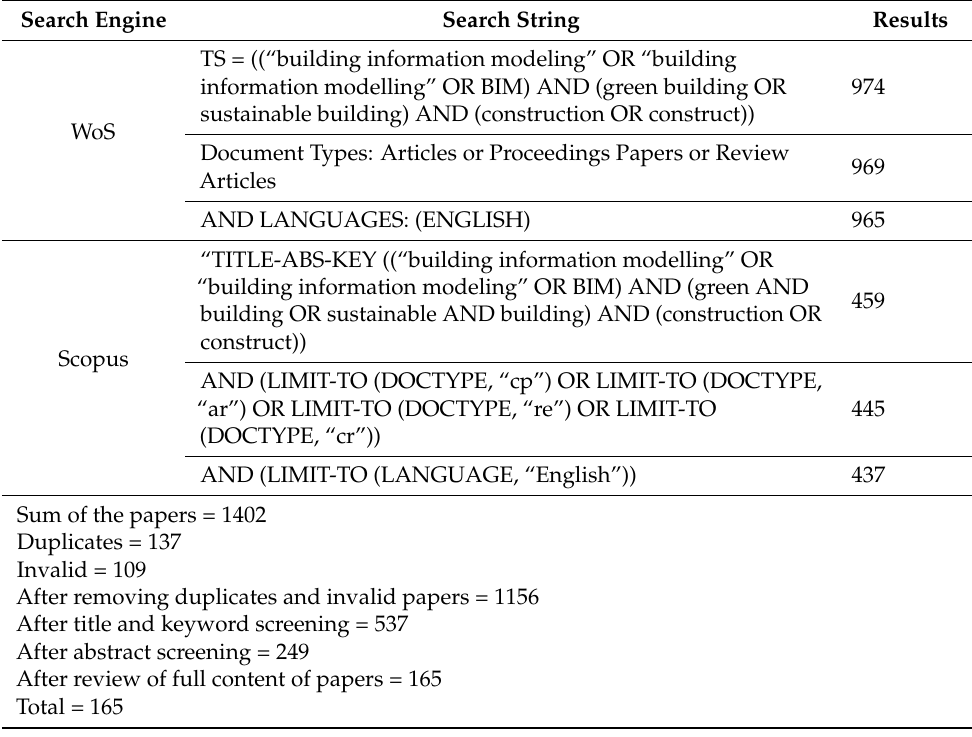
Table 1. Search string and initial search